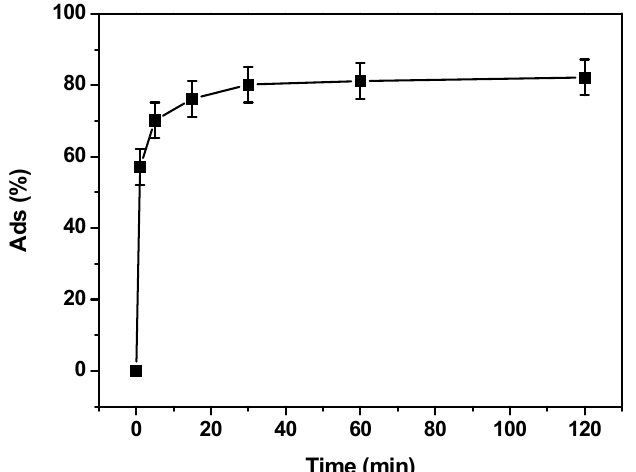
Figure 1. Effect of the contact time on the adsorption % of CBZ (5 mg/L) onto β‐ EPI polymer (25 g/L).